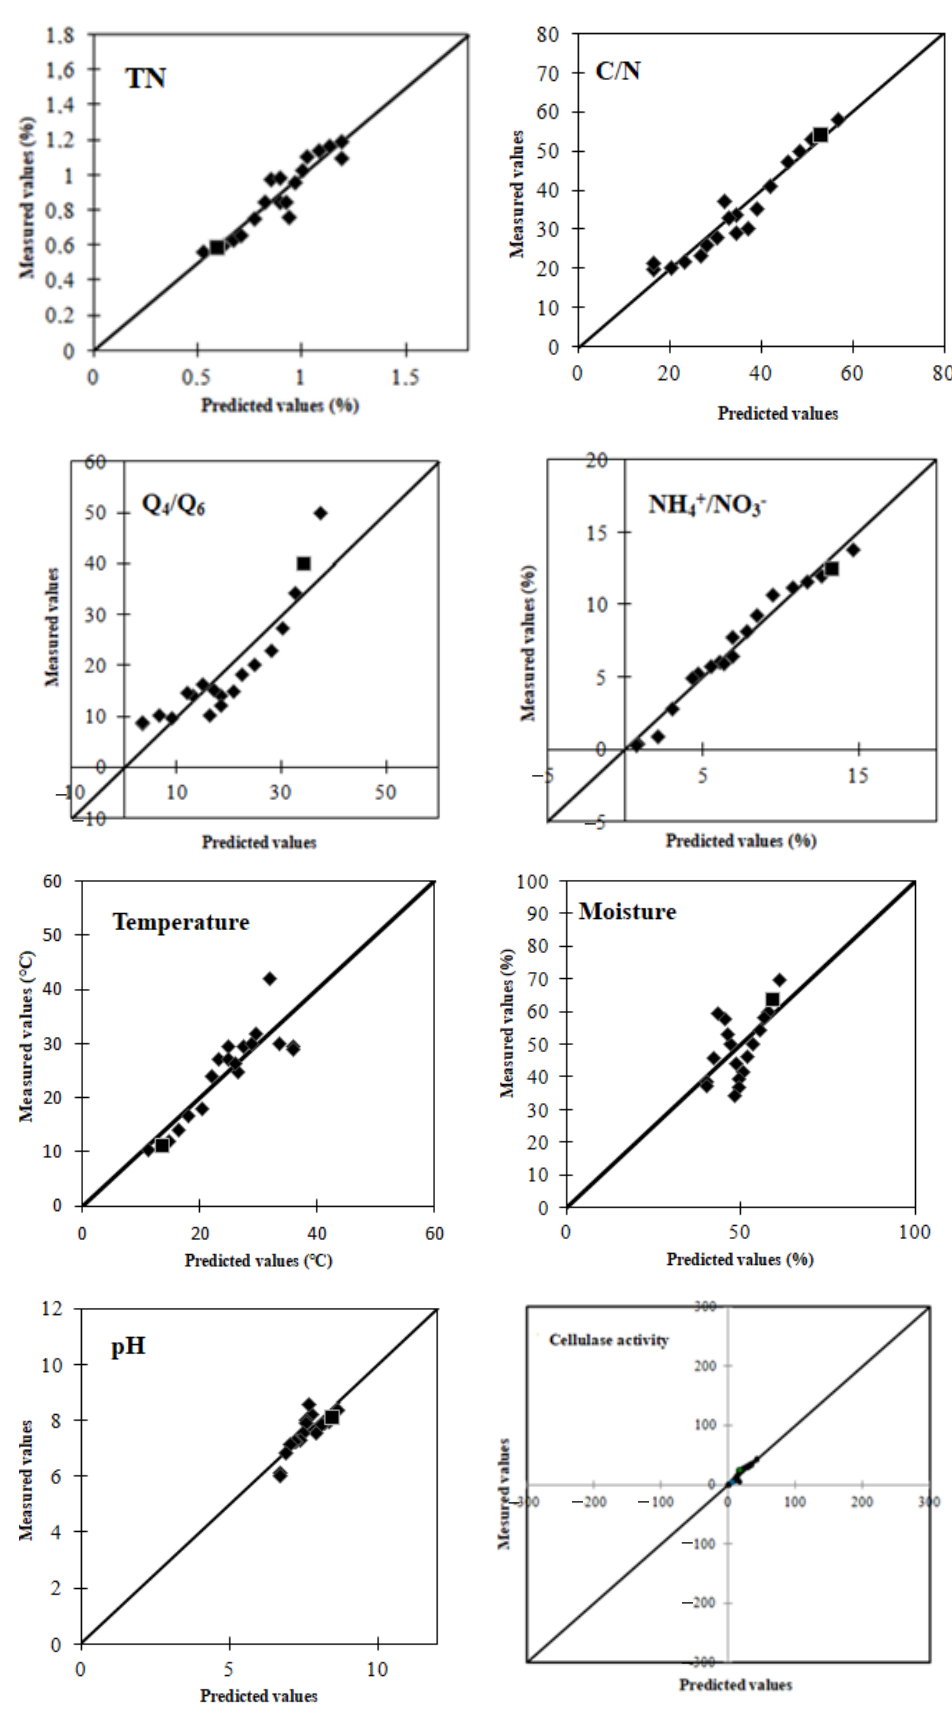
Figure 5. Prediction of the model using the partial least squares-regression.